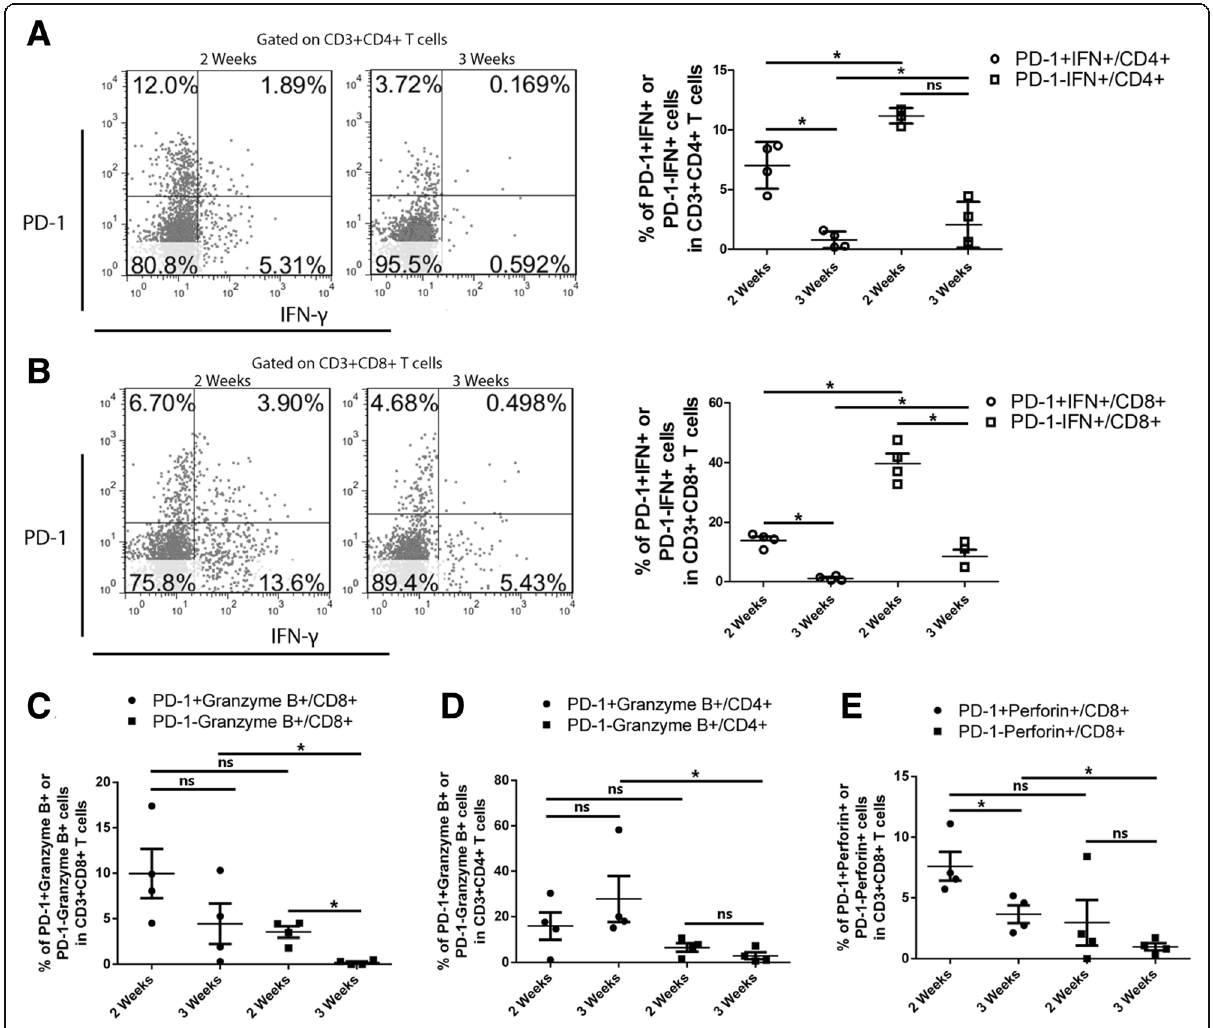
Fig. 2 Tumour infiltrating T cells isolated three weeks after transplantation are more inhibited Groups of four mice were subcutaneously inoculated with 2× 10 5 of TC-1 tumour cells in the flank. Mice were terminated at 2 or 3weeks after TC-1 tumour inoculation. Tumours were dissociated and digested with collagenous D and DNase I. Mononuclear cells were harvested by Ficoll separation and incubated with cell stimulation cocktail in the presence of monensin overnight at 37°C/5% CO 2 . Cells were surface stained for CD3, CD4 or CD8, and PD-1 followed by intracellular staining for IFN- γ , granzyme B or perforin. ( a) Percentage PD-1+IFN- γ +or PD-1-IFN- γ +of CD3+CD4+ cells; ( b) Percentage of PD-1+IFN- γ +or PD-1-IFN- γ +of CD3+CD8+ cells; ( c ) Percentage of PD-1+ granzyme B+ or PD-1- granzyme B+ of CD3+CD8+ cells; (d) Percentage of PD-1+ granzyme B+ or PD-1- granzyme B+ of CD3+CD4+ cells; ( e ) Percentage of PD-1+ perforin+ or PD-1- perforin+ of CD3+CD8+ cells. The results represent one of two independent